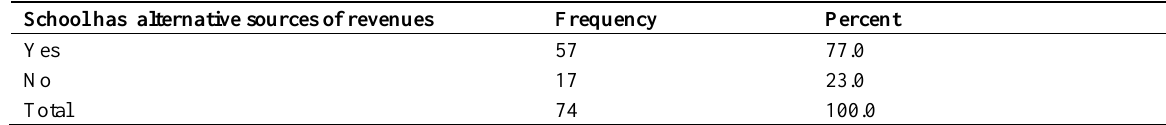
Table 3: Distribution of Parents based on whether School has Alternative Revenues